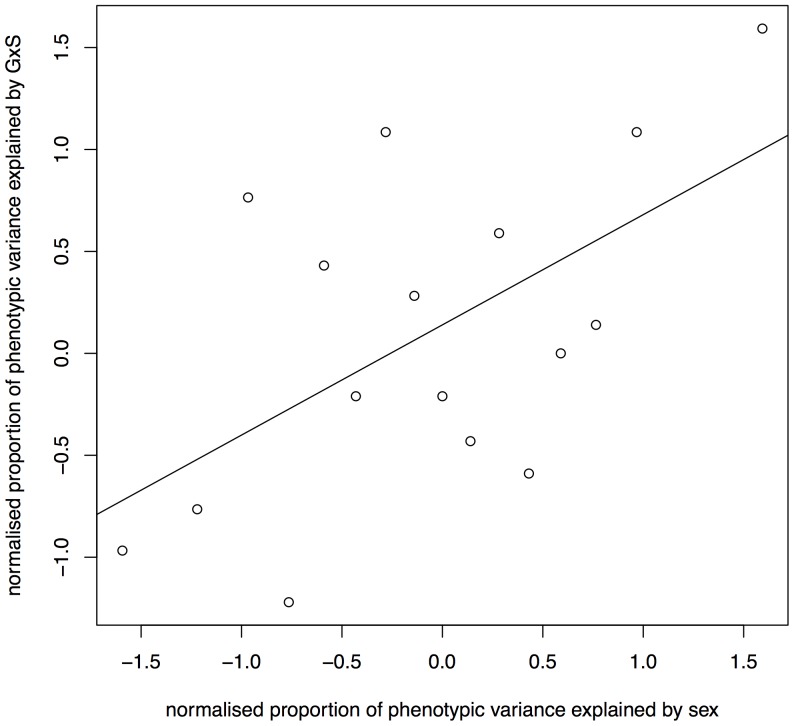
Correlation between GxS and main effect of sex.The proportion of phenotypic variance explained by sex as a main effect is plotted on the horizontal axis and the proportion of variance explained by the interaction effect is shown on the vertical axis. The two correlate with a P value <0.05.